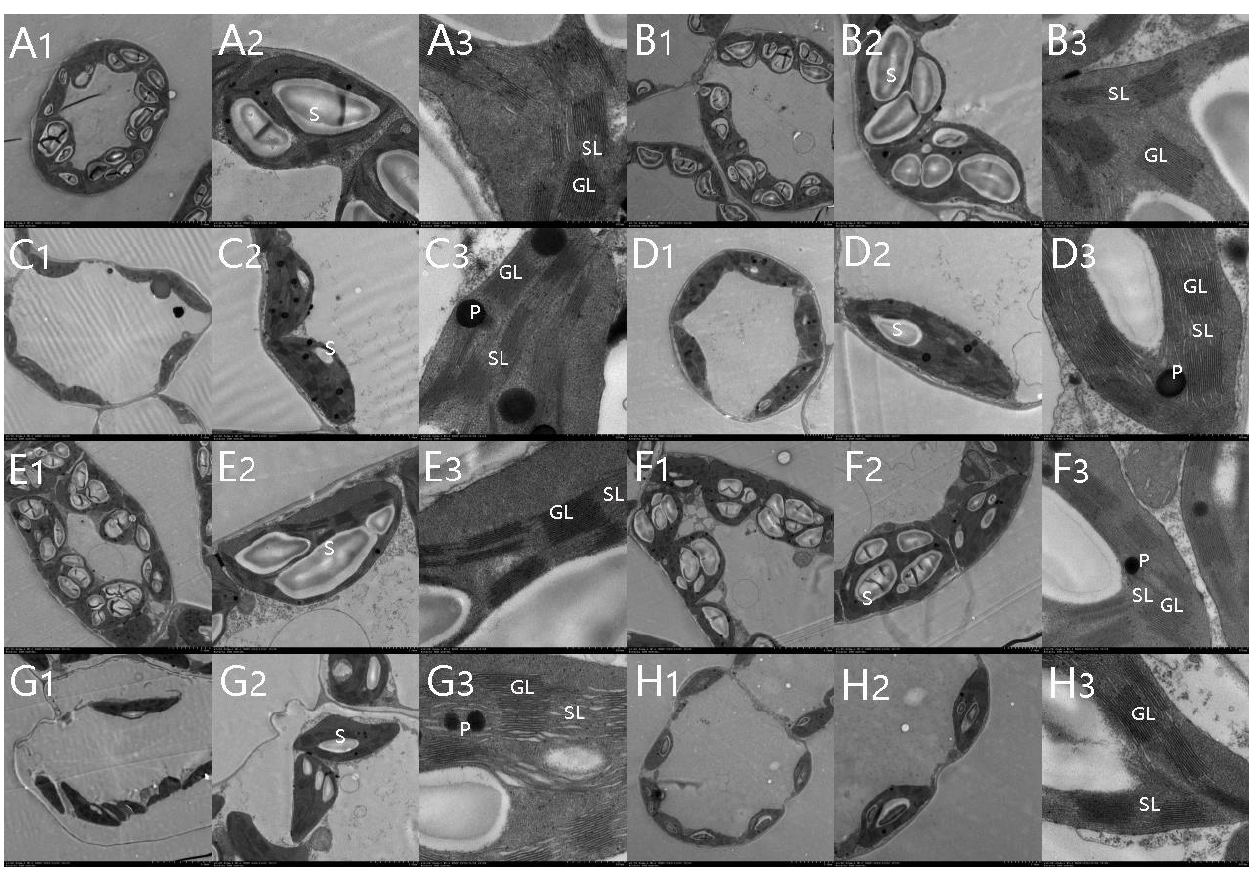
Figure 6. Comparison of chloroplast ultrastructure between salt-resistant and salt-sensitive tomato seedlings under salt stress. Salt resistance genotype: Control ( A1 – A3 ), spraying melatonin under normal condition ( B1 – B3 ), salt stress ( C1 – C3 ), spraying melatonin under salt stress ( D1 – D3 ); salt- sensitive genotype: Control ( E1 – E3 ), spraying melatonin under normal conditions ( F1 – F3 ), salt stress ( G1 – G3 ), spraying melatonin under salt stress ( H1 – H3 ). P: plastoglobulus; S: starch grains; GL: